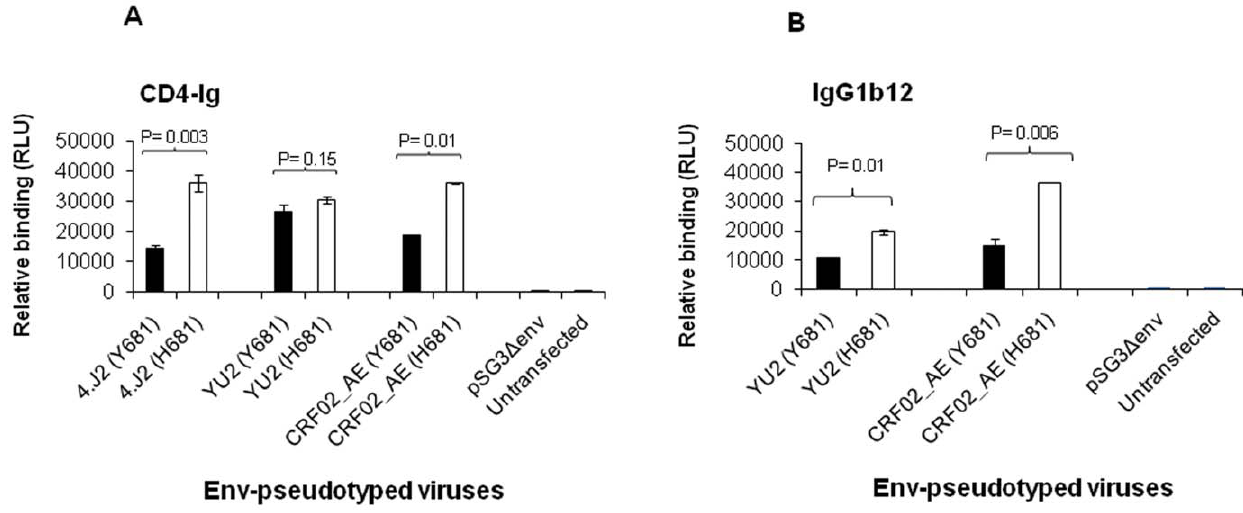
Figure 5. Effect of Y681H on relative binding of gp120 with CD4. Cell-based enzyme-linked Immunosorbant assay (CELISA) was carried out with indicated Envs. The relative binding of (A) CD4-Ig and (B) IgG1b12 to Env trimers expressed on 293T cells was measured as relative luminescence units (RLU) on Y-axis. pSG3 D env and untransfected 293T cells were taken as negative control.